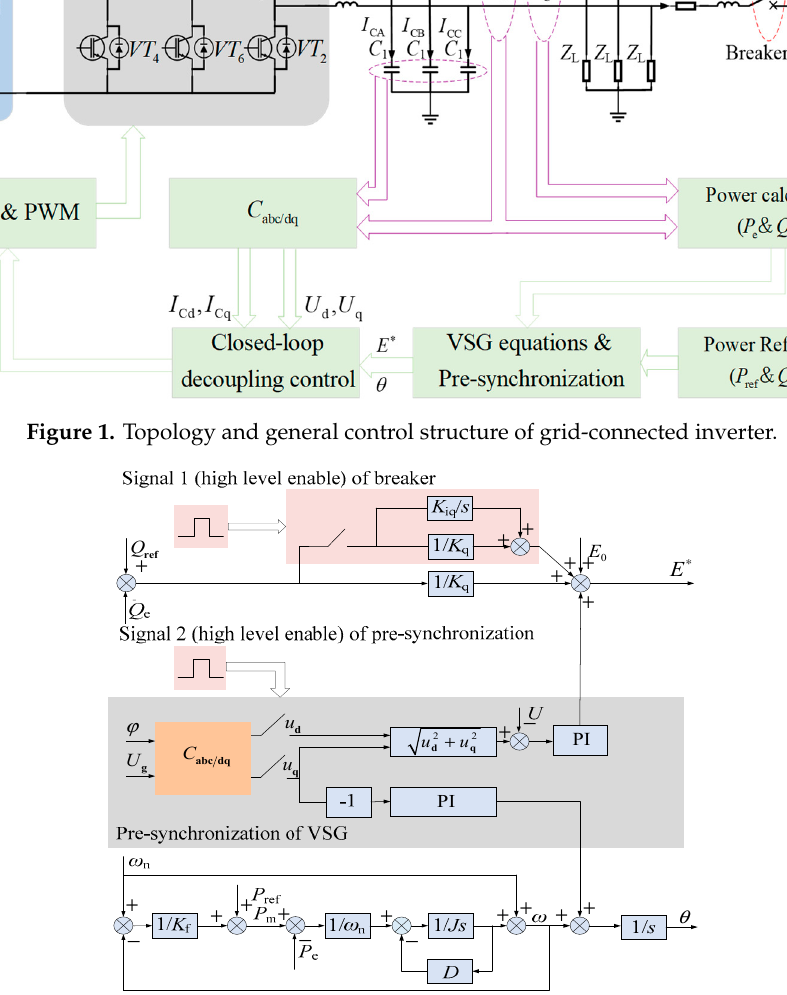
Figure 2. Overall schematic control diagram of grid-connected virtual synchronous generator (VSG).